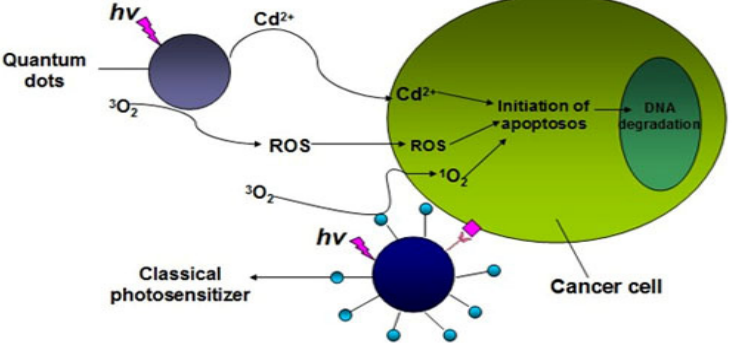
Figure 4. Schematic representation of possible mechanisms for induction of PDT processes by QDs and the classical